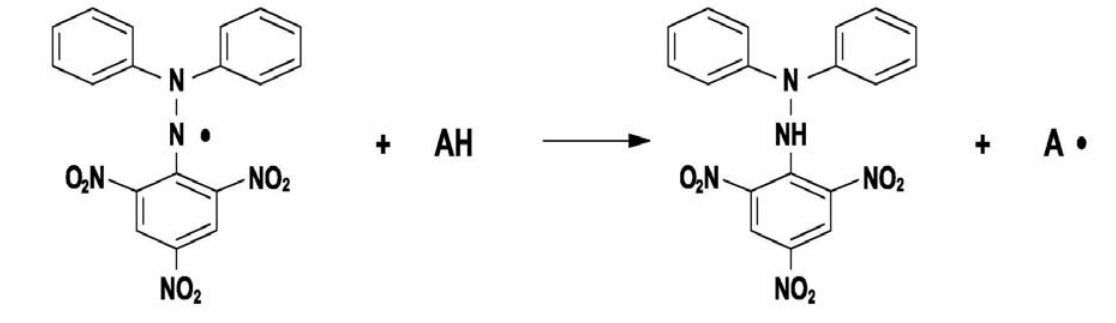
Figure 1 . Reaction of DPPH· free radical with an